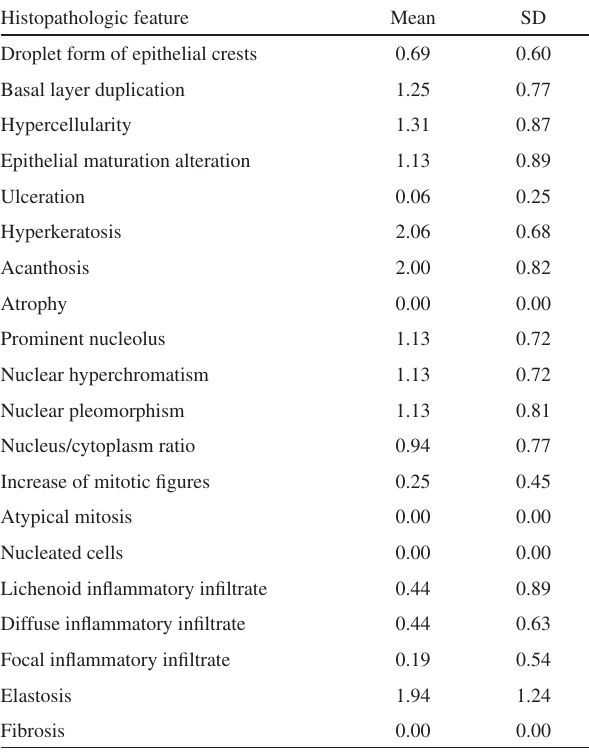
Table 3 - Mean scores of the histopathologic features ob- served in 16 lower-lip